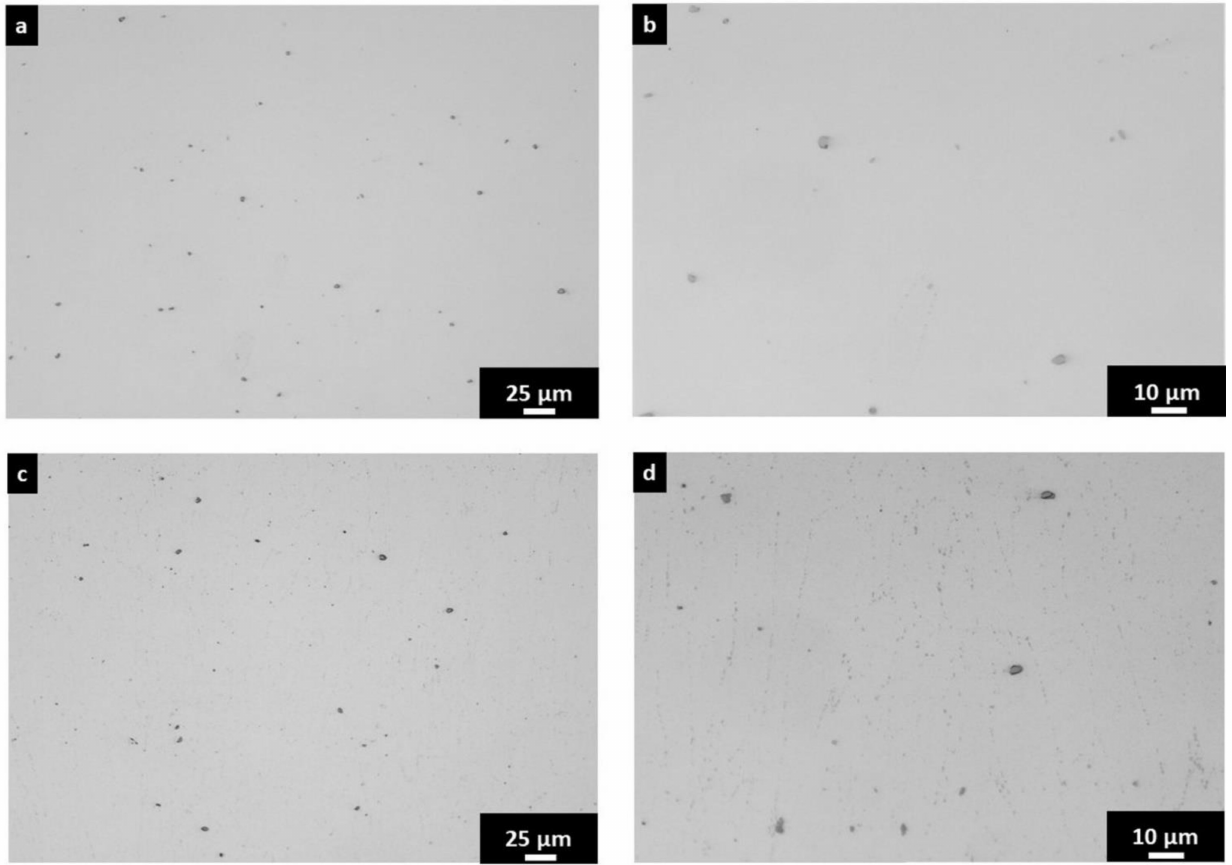
Figure A1. LOM images at different magnifications of the polished ( a , b ) AB IN625/TiC and ( c , d ) SOL IN625/TiC samples along the building